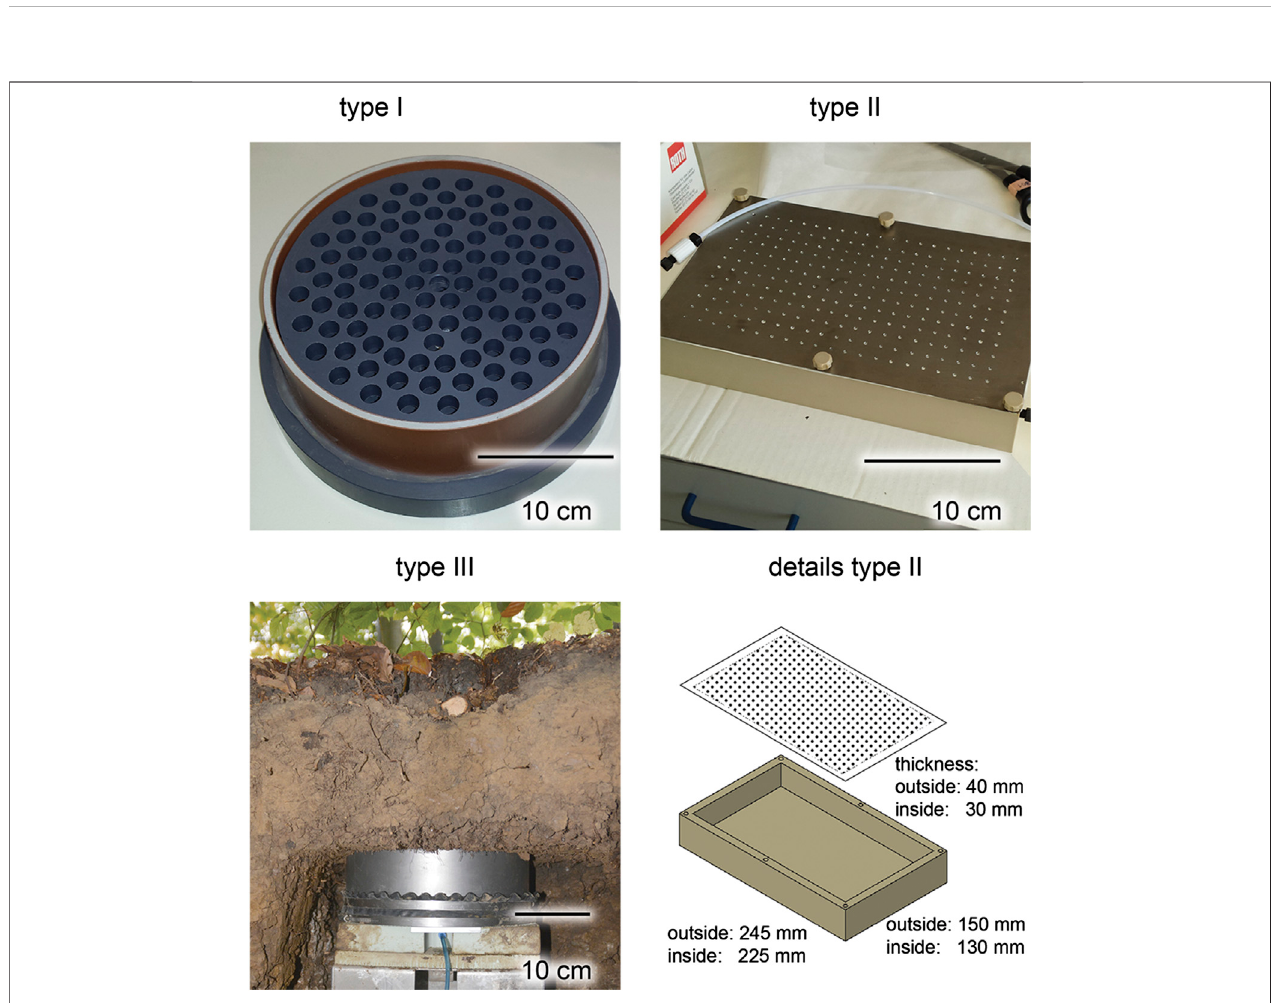
FIGURE 2 | Images and technical drawing of lysimeters used in this study. Type I is made of poly vinyl chloride (PVC), type II of poly ether ether ketone (PEEK) and titanium, type III is made of stainless steel and glass.